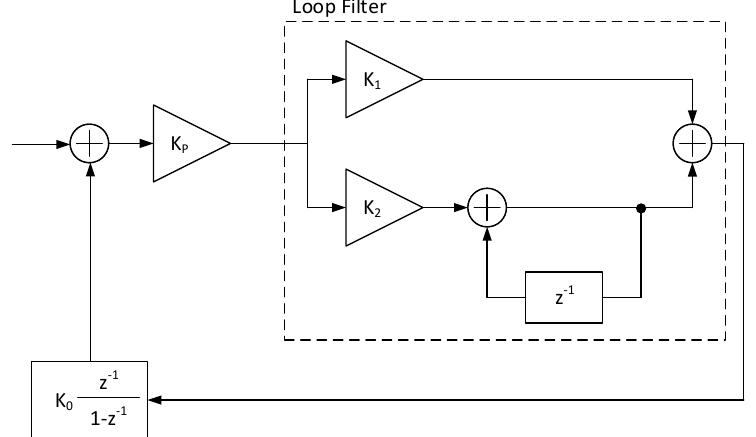
Figure 9. Generic system level view of a second order loop filter.